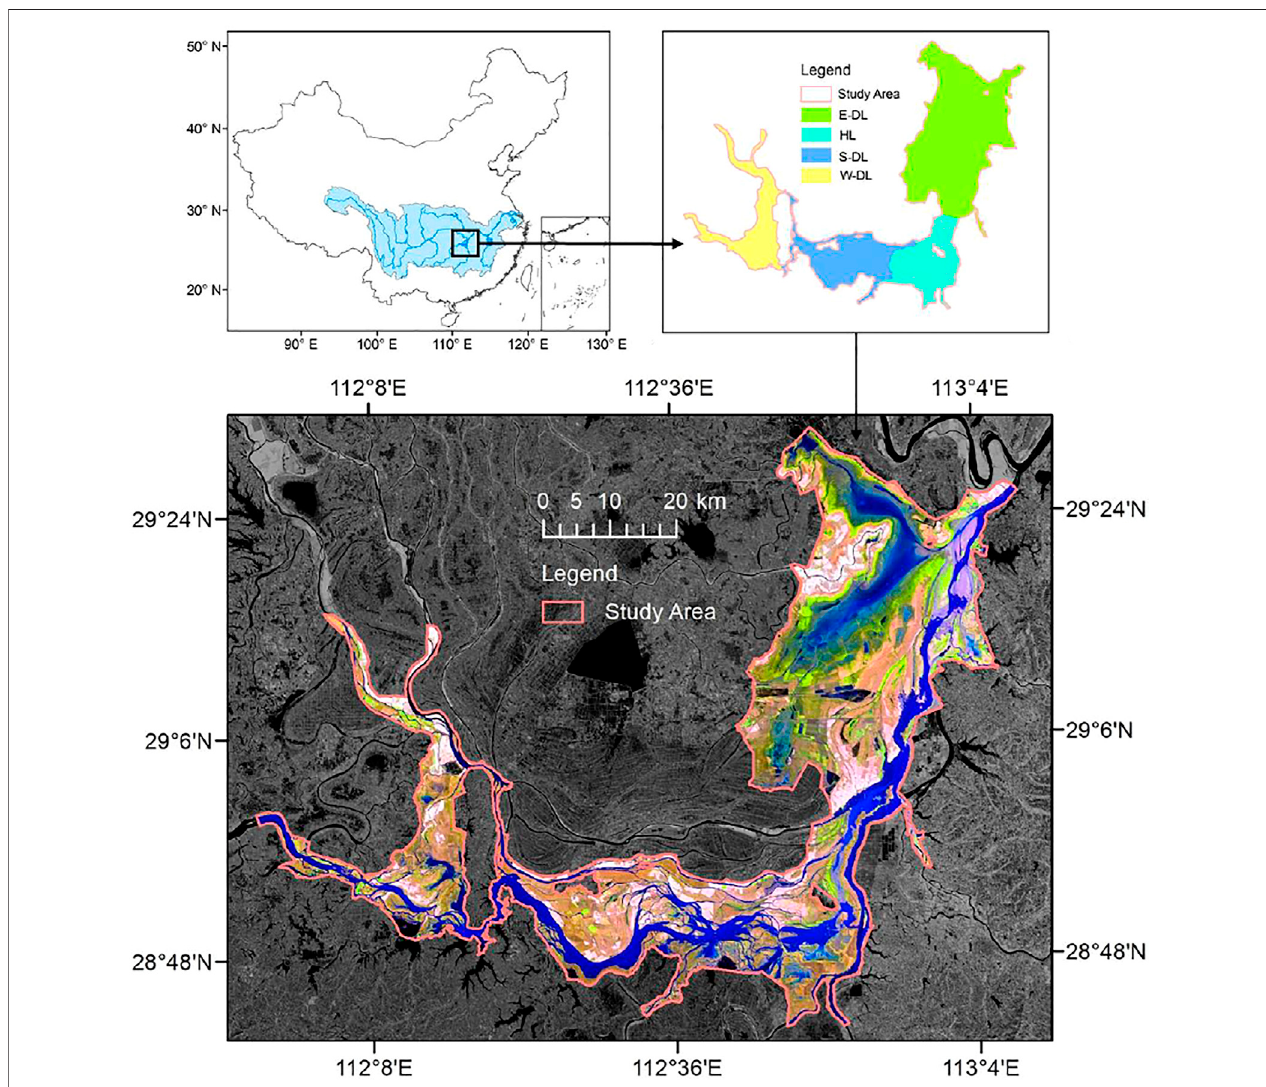
FIGURE 1 | The location of Dongting Lake (DL) and the range of East Dongting Lake (E-DL), Hengling Lake (HL), South Dongting Lake (S-DL) and West Dongting Lake (W-DL).